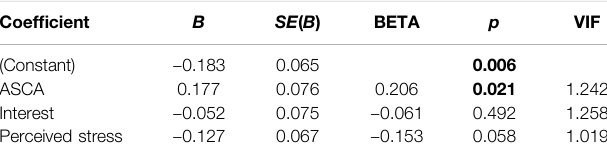
TABLE 9 | Linear regression analysis with variables ASCA, interest and perceived stress as predictor variables for LF/HF ratio (for the total sample). Coef fi cient B